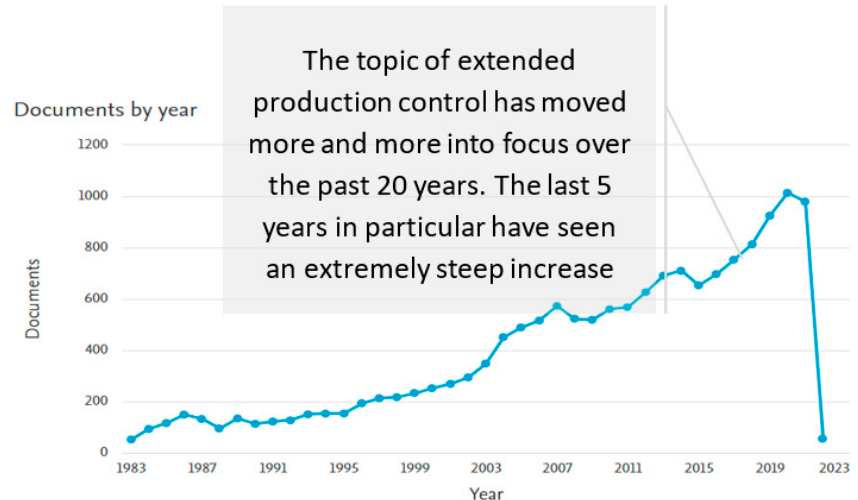
Figure 11. SCOPUS: advanced AND production AND control—Documents by year.